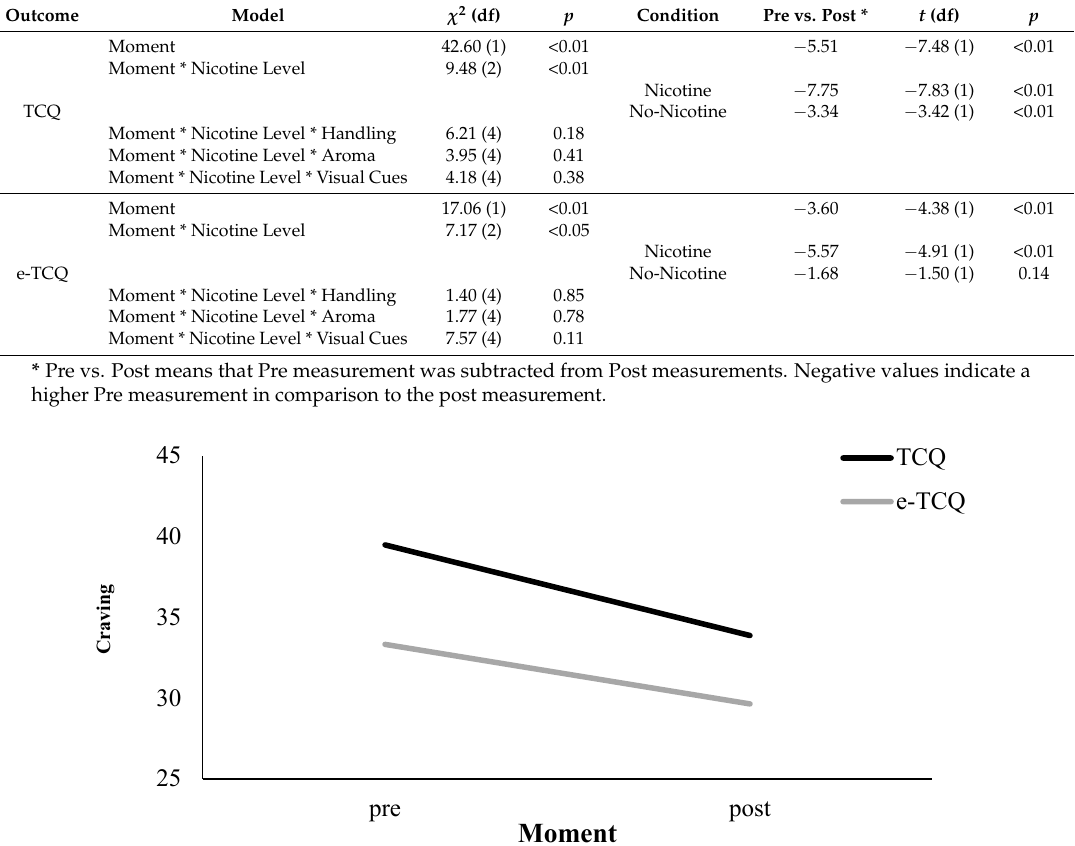
Table 1. Results of the mixed-effects models with respect to tobacco craving questionnaires (TCQ) and e-TCQ.